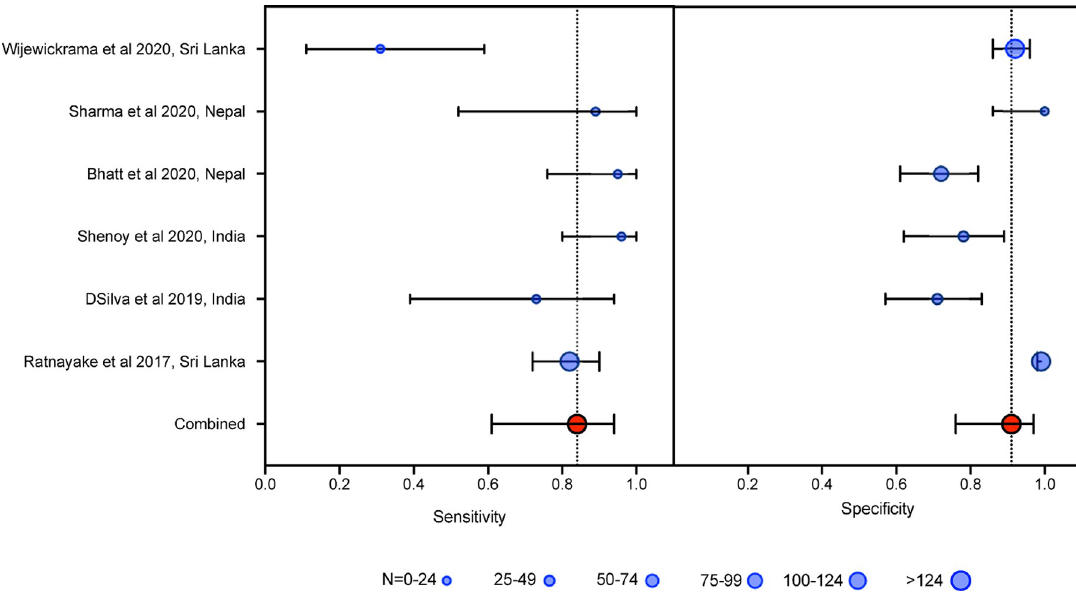
Fig 2. Forrest plot of 20WBCT sensitivity and specificity at detecting coagulopathy, Forrest plot of 20WBCT sensitivity and specificity at detecting coagulopathy defined as INR > 1 � 4. Studies displayed individually and pooled. Circle size is proportional to sample size, whiskers represent 95% confidence interval.